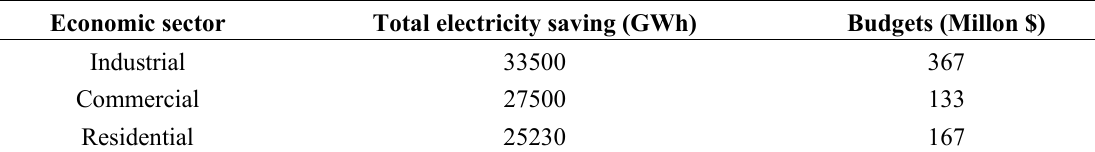
Table 4. Energy savings due to NECP and related